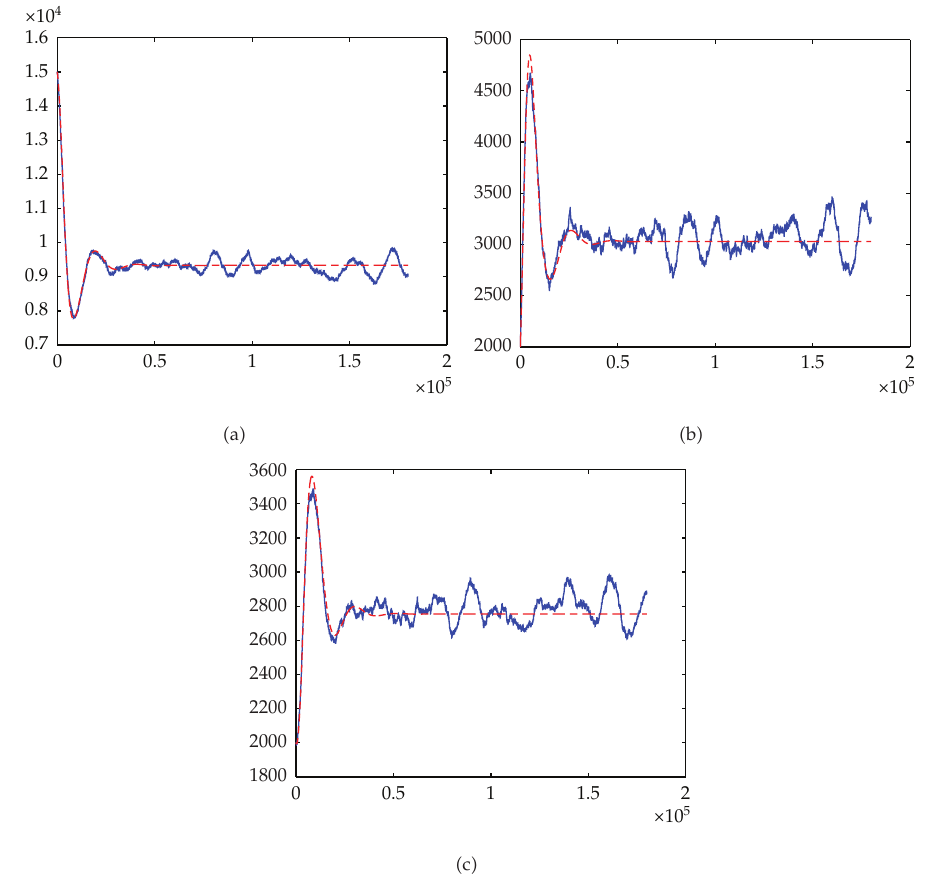
Figure 3: Deterministic and stochastic trajectories around virus endemic